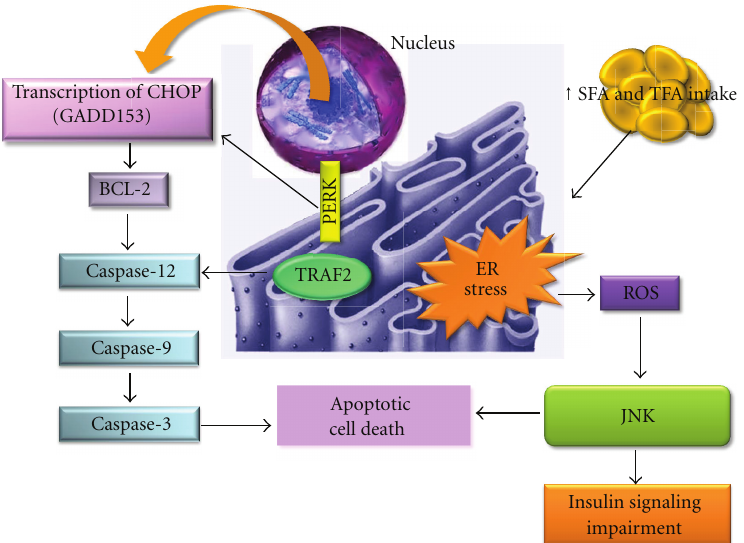
F 4: Schematic representation of SFA and TFA excess intake effects in endoplasmatic reticulum stress. BCL-2: B-cell lymphoma